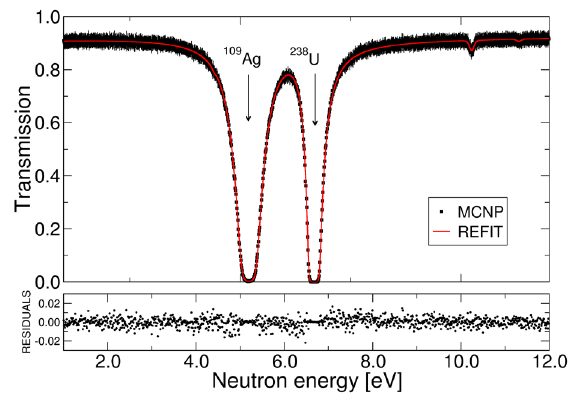
Figure 3. Sample-in spectra from the transmission measurement with the AG9C1 sample. Data are compared with the total back- ground (red line). Black resonances due to the presence of the fixed black resonance filters and black resonances due to nuclides present in the sample are indicated.